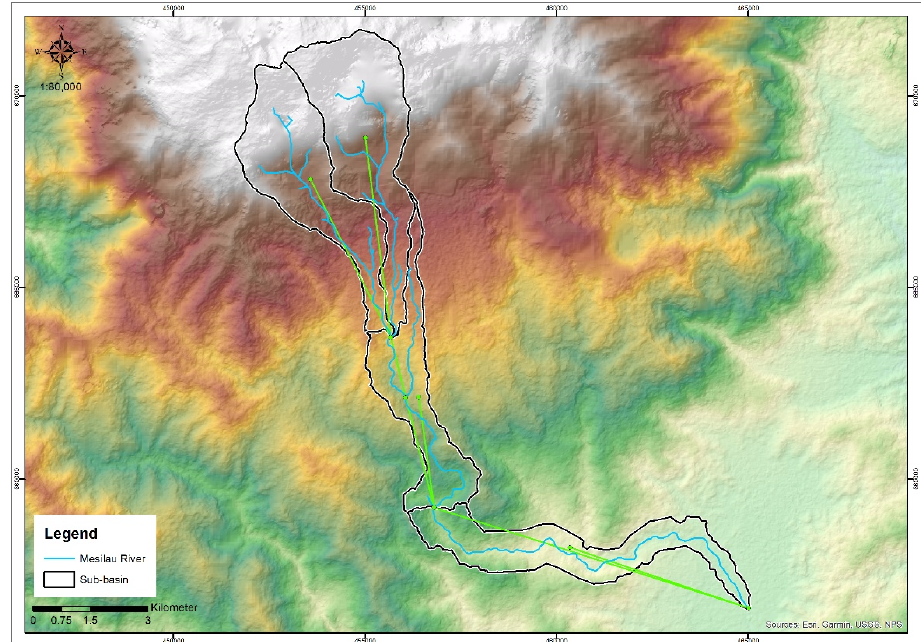
Figure 8. The base model extracted using the ArcHydro and Hec-GeoHMS extensions. To model the debris flow, the outline shapefile of the overall watershed area (*.shp) was used to clip the raw IfSAR DTM (*.tiff) in order to obtain the boundary of the watershed area. Figure 9 shows the clipped IfSAR DTM (*.tiff) following the shapefile boundary of the watershed area (yellow). Yellow dots along the channelised river represent the distance of the past debris flow runout for every 100 m. The total debris flow runout was 18,600 m (18.6 km), with 187 dots from the initiation to the deposition area. Then, the watershed area (*.tiff) was imported into the open-source QGIS software to model the debris flow.